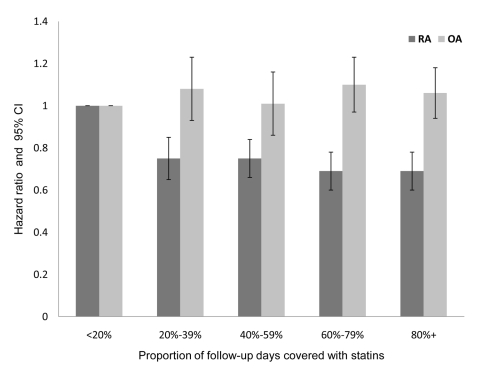
Adjusted HR and 95% CI for RA and OA, according to PDC with statins in patients with at least 5 y of follow-up.Adjusted for baseline values of age, sex, socioeconomic level, utilization of healthcare services in the year prior to index date, chronic comorbidity (cardiovascular diseases, diabetes mellitus, cancer, morbid obesity), LDL level, and statin efficacy.